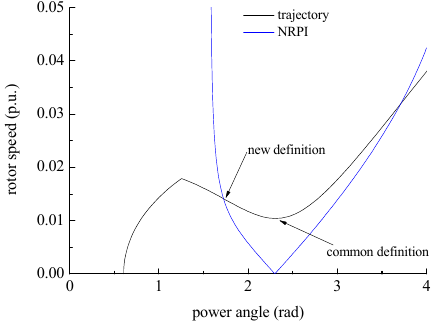
Figure 1. System trajectories of a SMIB.